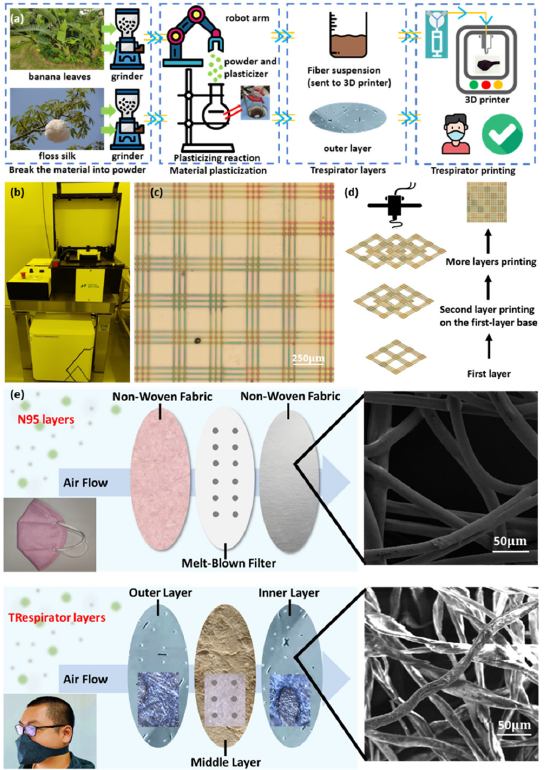
Figure 1. The synthesis and structure of the TRespirator and comparison to a N95 mask. ( a ) The reaction process of preparing banana leaf fibers and floss silk fibers, which are the components of the inner layer and two outer layers, respectively. After the plasticizing reaction, the fiber suspension of banana leaves was sent to the 3D printer to fabricate the middle layer. ( b ) The overall photo of the 3D printing machine, ( c ) the printed single layer of the middle layer of the TRespirator, ( d ) the schematic process diagram of multiple-layer printing, ( e ) the 3-layer-structure comparison between the N95 mask and the TRespirator, with two outer layers blocking big impurities, and the inner layer filtering small particles. Grey dots indicate the electrostatic electret